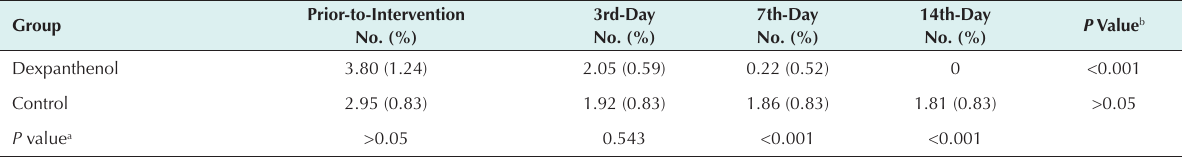
Table 4. Comparison of Trauma Scores in Dexpanthenol and Control Groups at 4 Timepoints Group